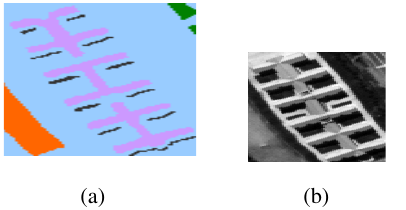
Figure 5. True hyperspectral dates : (a)True distribution, (b) 60 th band grey image.